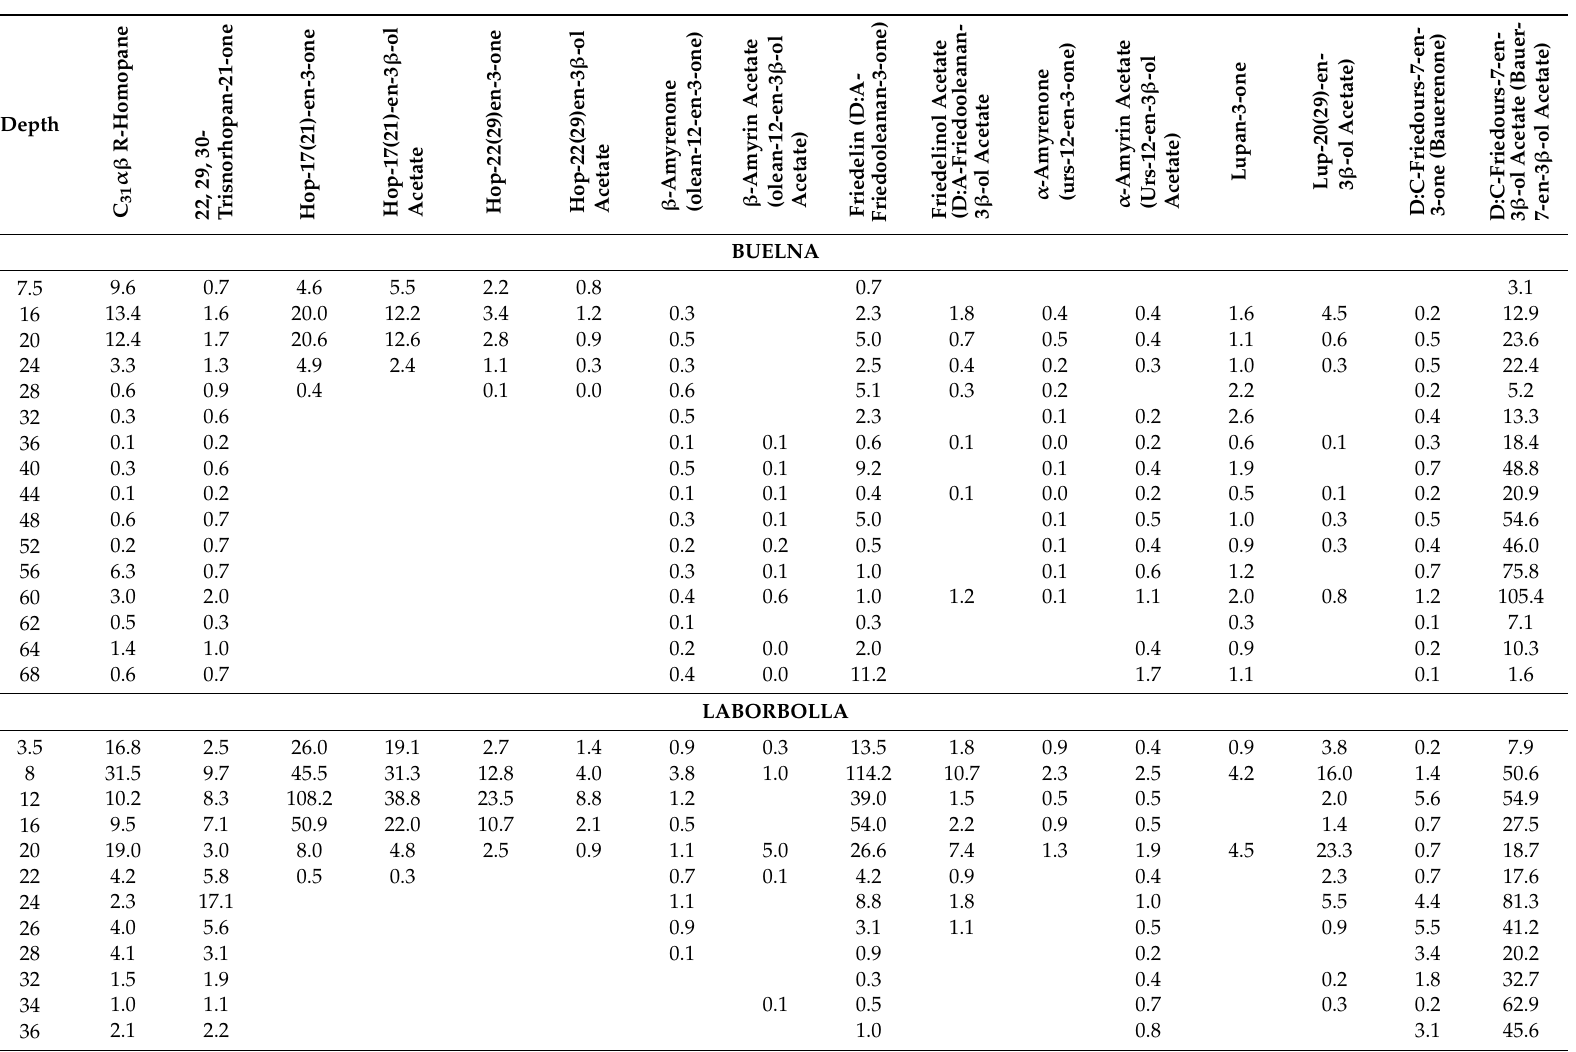
Table 3. Concentrations of triterpenoid derivatives ( µ g / g Corg) in the Buelna, La Borbolla, and Pendueles